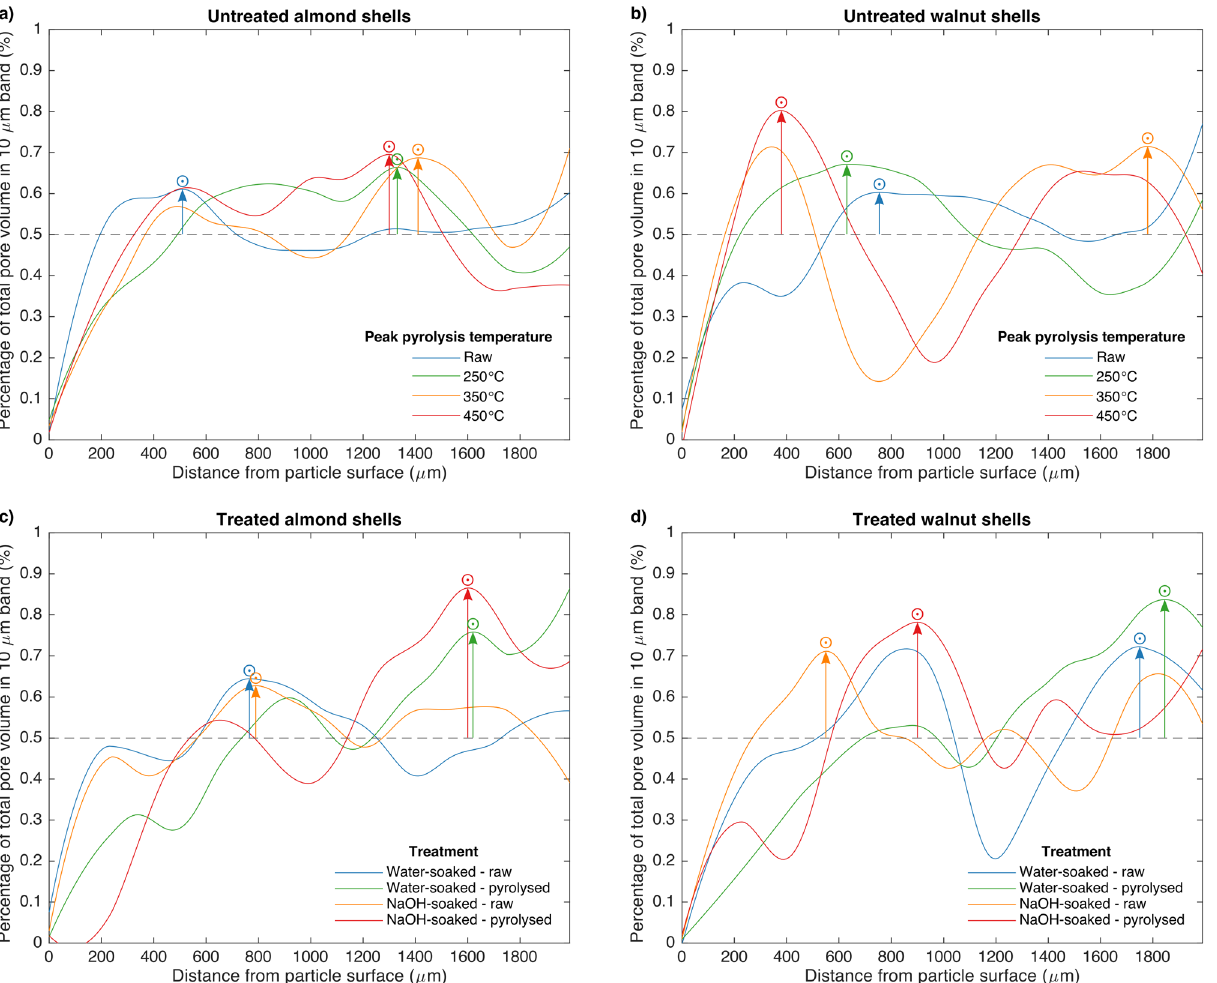
Figure 5. Distributions of pores in biomass beds with respect to the distance of their centres of mass from the nearest exposed particle surface for ( a ) untreated almond shells, ( b ) untreated walnut shells, ( c ) pretreated almond shells and ( d ) pretreated walnut shells. The volume of pores in each of two hundred 10 μm wide bins were summed to give an indication of where within particles the bulk of pore volume is located with respect to exposed surfaces. The greatest local maximum of each distribution is indicated by the symbol ⨀ . The displacements of these maxima from the “equal distribution line” at 0.5%, normalized by the greatest observed value of this displacement, are termed “degree of pore concentration”, and represented by the symbol ⨀ , the values of which are plotted in Fig. errors (cropped edges are not considered particle surfaces in calculations). Because two hundred 10 μm bands were considered, a flat distribution at 0.5% represents an equal volume of pores in each band. Notably, this equal distribution of pore volume is not equivalent to an even distribution of pore volume throughout the particle, which would lead to a peak in pore volume at the particle surface, as discussed above. Therefore, while a peak at the surface can signify either an even distribution of pore volume or a concentration of pore volume towards par- ticle surfaces, a peak elsewhere clearly signifies a concentration of pore volume in this region. Figure 6 provides examples to guide interpretation of these distributions. Begin by considering the “ideal” situations described in the rightmost column, then consider the situations presented moving leftwards as examples of how surface peak meaning may be convoluted, while peaks far from particle surfaces retain their meaning regardless of intensity. Because tomography was performed ex-situ, and biomass begins with an effectively random distribution of pores, the distributions presented in Fig. 5 cannot be directly compared to one another. Despite this, the height of the maximum peak in each distribution, which represents a measure of the degree to which pores are con- centrated with respect to distance from a particle surface, trends upward with peak pyrolysis temperature, and is consistently greater in pyrolysed samples than raw samples for both treated and untreated shells (see Fig. 7). This metric, calculated as the displacement of the maximum peak in pore volume with respect to distance from a particle surface from the equal distribution line (0.5%), normalised by the greatest observed value of this dis- placement, will be termed the degree of pore concentration, and represented by the symbol ⨀ .